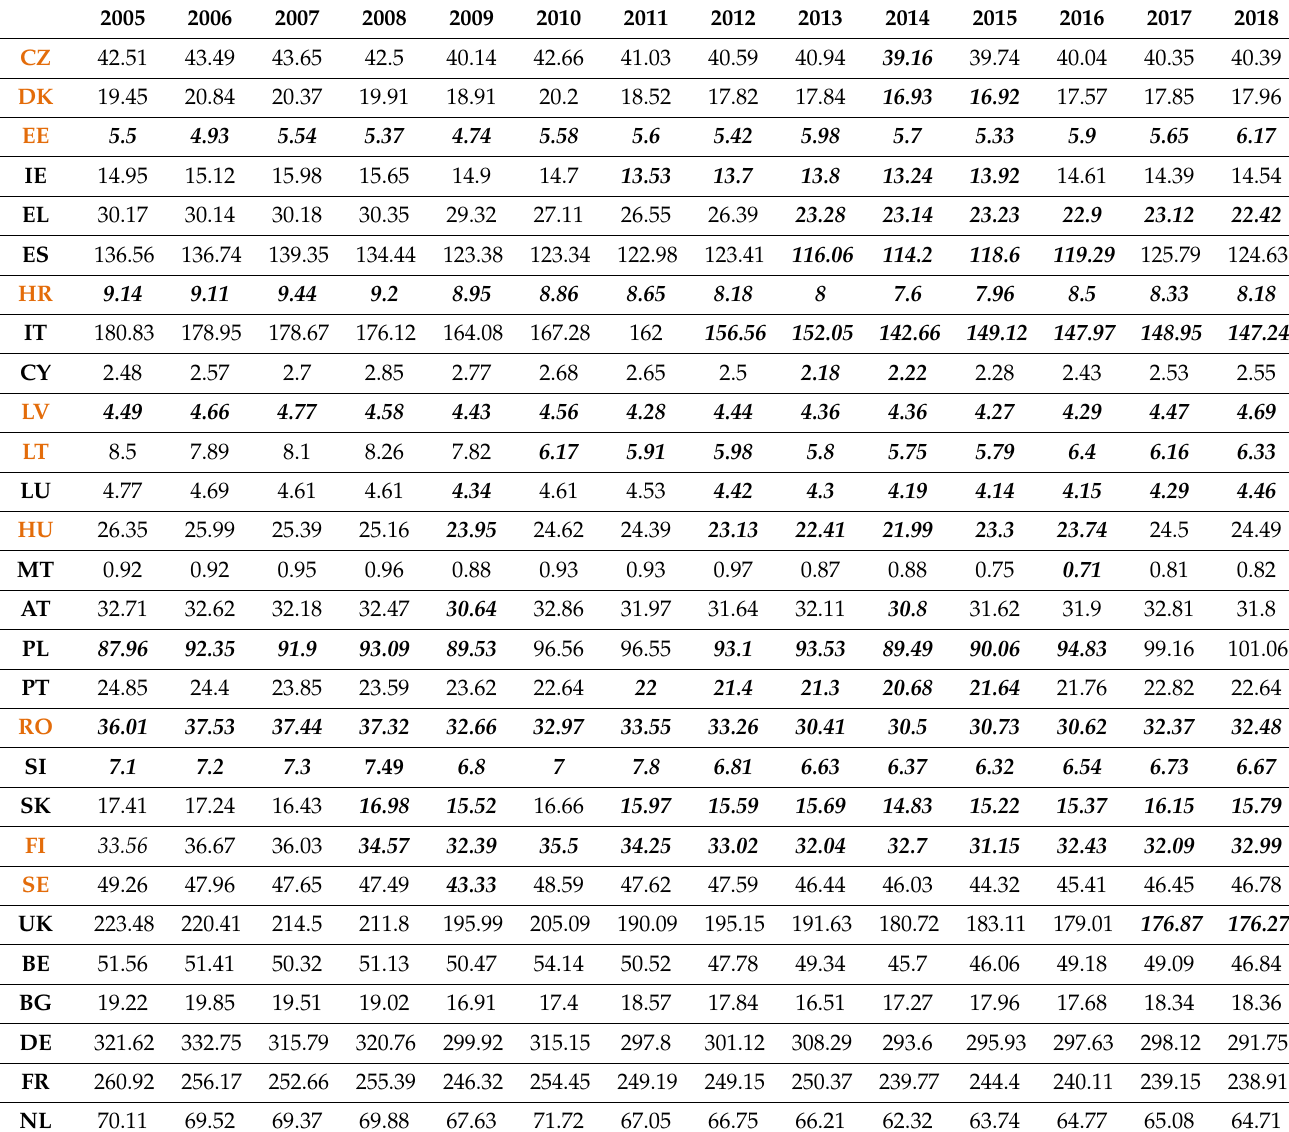
Table 3. Primary energy consumption in million t nnes of oil